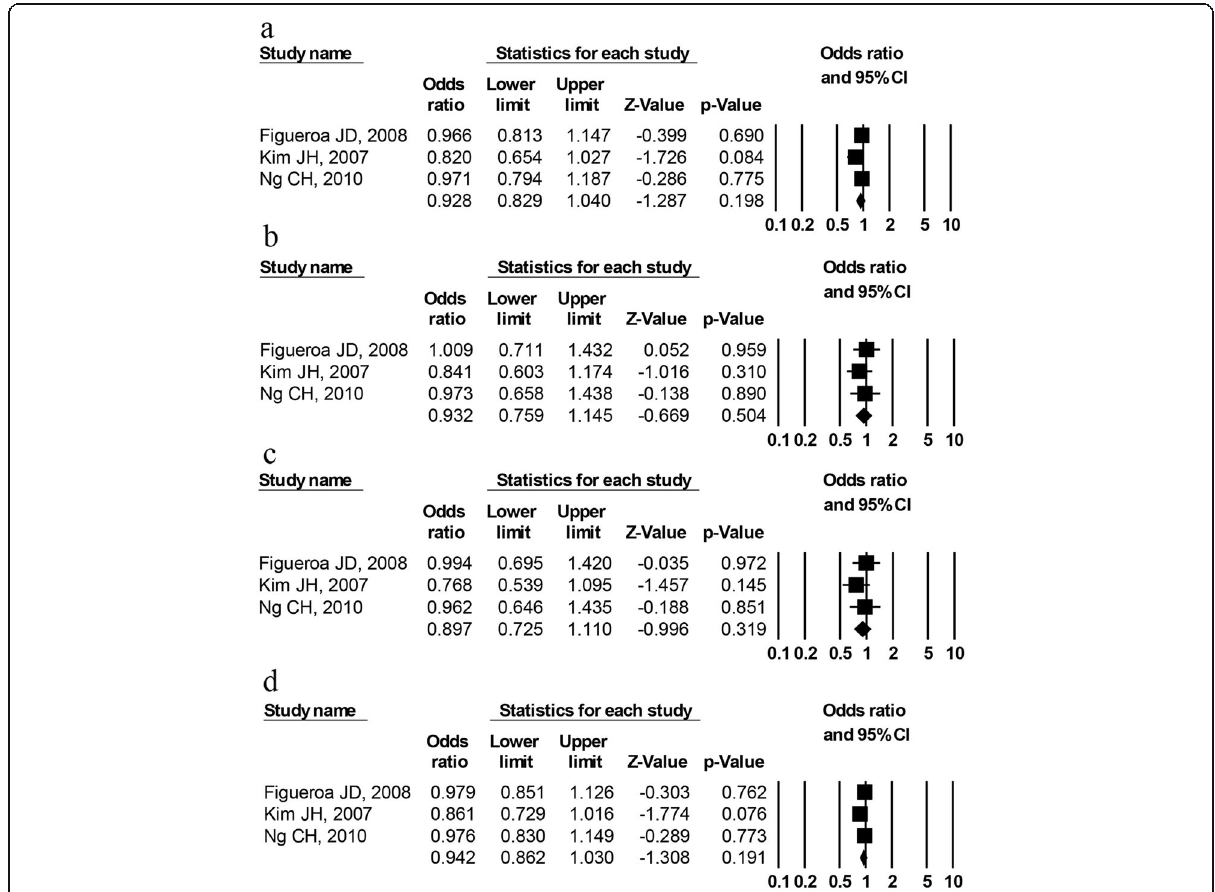
Fig. 4 Forest plot for AhR rs7796976 polymorphism and the overall cancer risk. a Dominant model (AA+GA vs. GG), b recessive model (AA vs. GA+GG), c codominant model (AA vs. GG), and d allelic model (A vs.